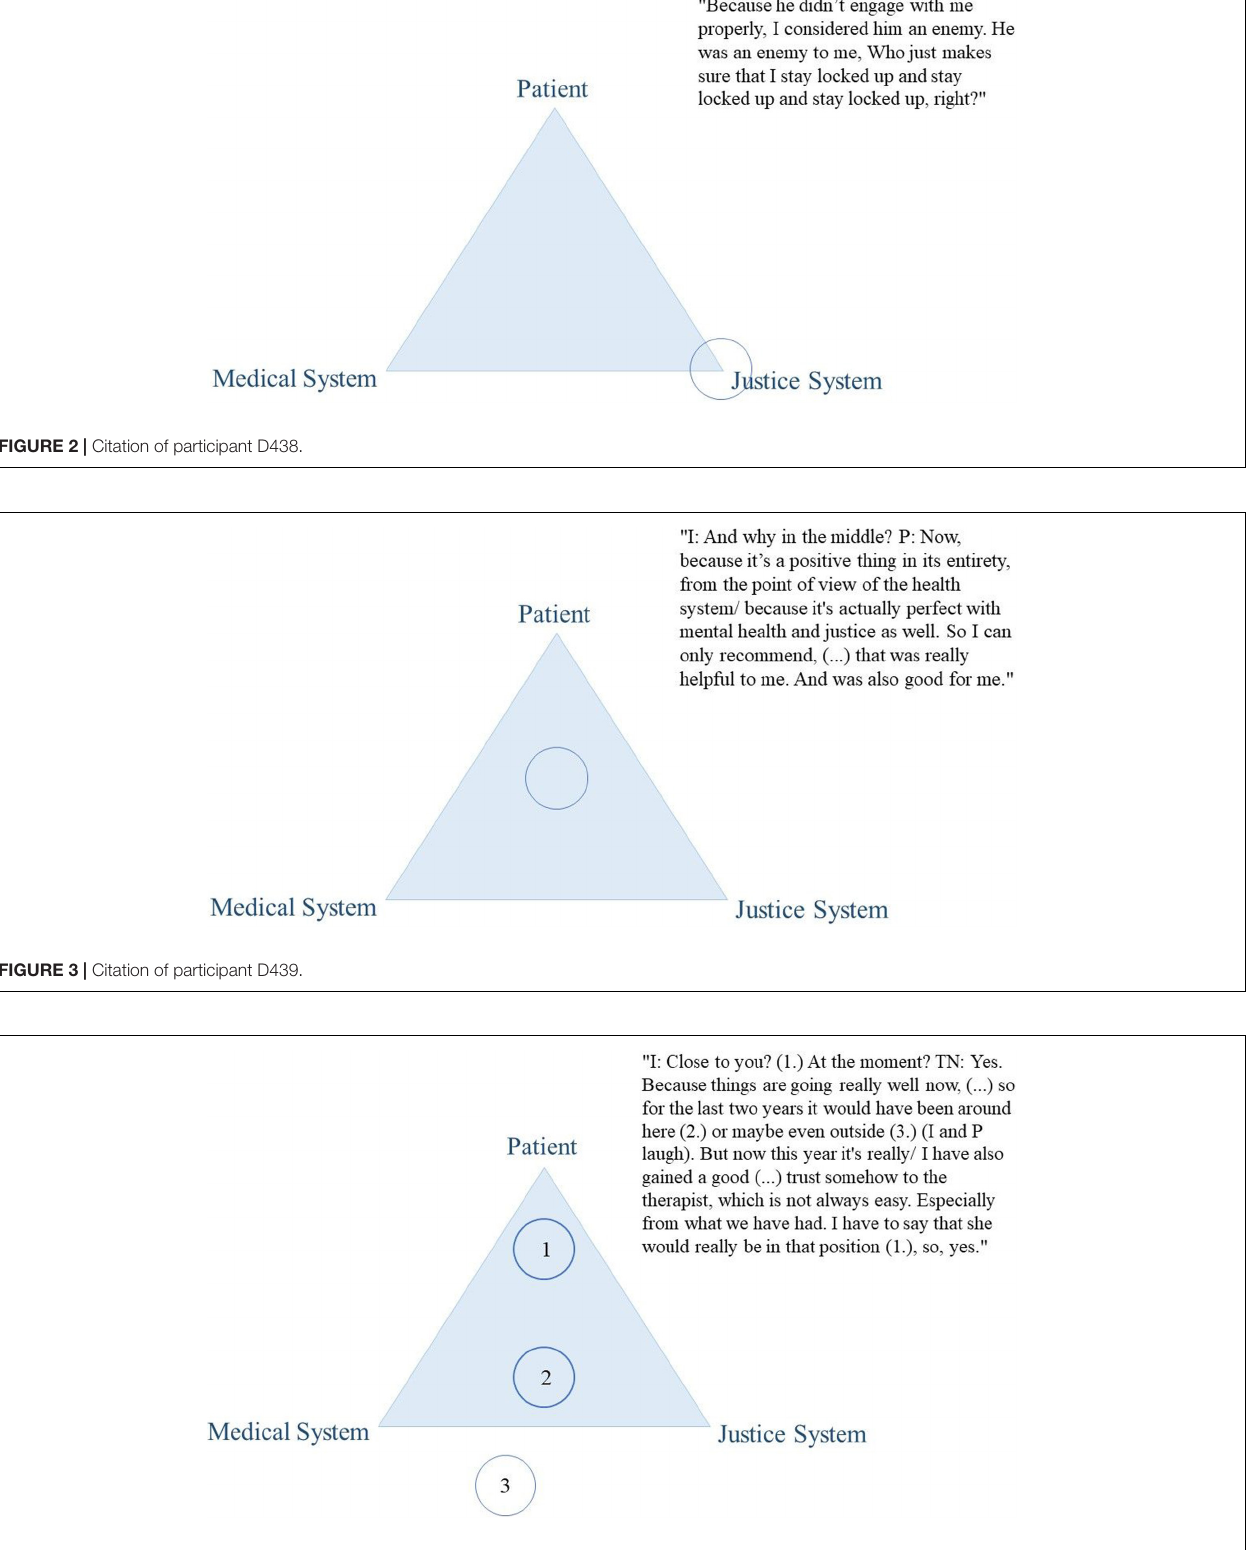
FIGURE 4 | Citation of participant